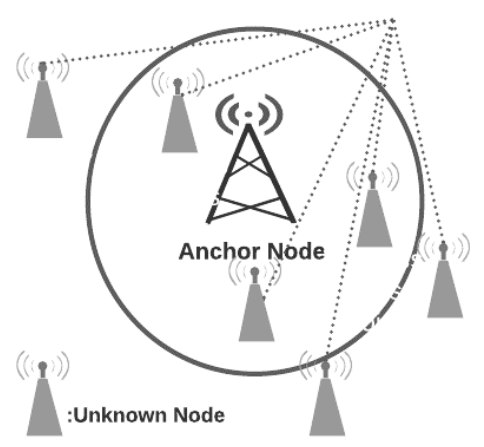
Figure 6. Received signal strength indicator.